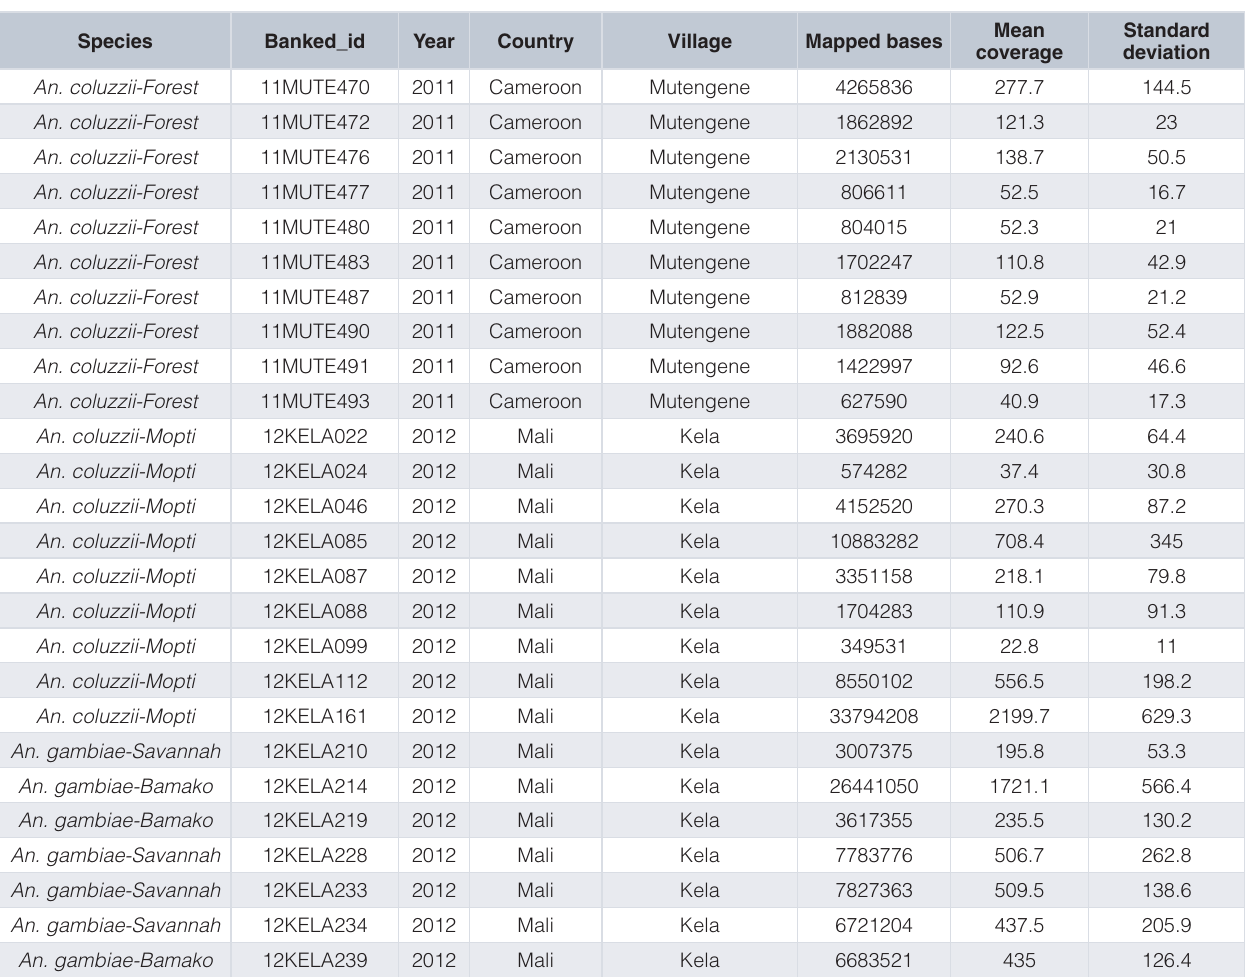
Table 2. List of samples that are used for the study. Mapped reads indicates the reads that are mapped to the reference genome. Mean coverage indicates the average depth of reads on the mitochondrial DNA and standard deviation indicates the coverage deviation across the mitochondrial